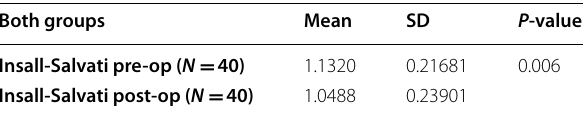
Table 9 Difference in Insall‑Salvati index in both groups pre‑ operative